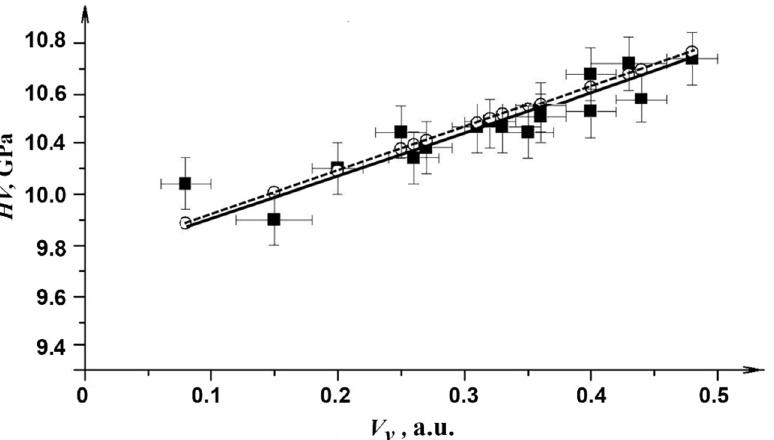
Figure 6. Microhardness as a function of the volume fraction of the crystalline phase for different annealing modes of the Fe 70 Cr 15 B 15 А A: ○ —data calculated by Equation (3); ■ —experimental data.